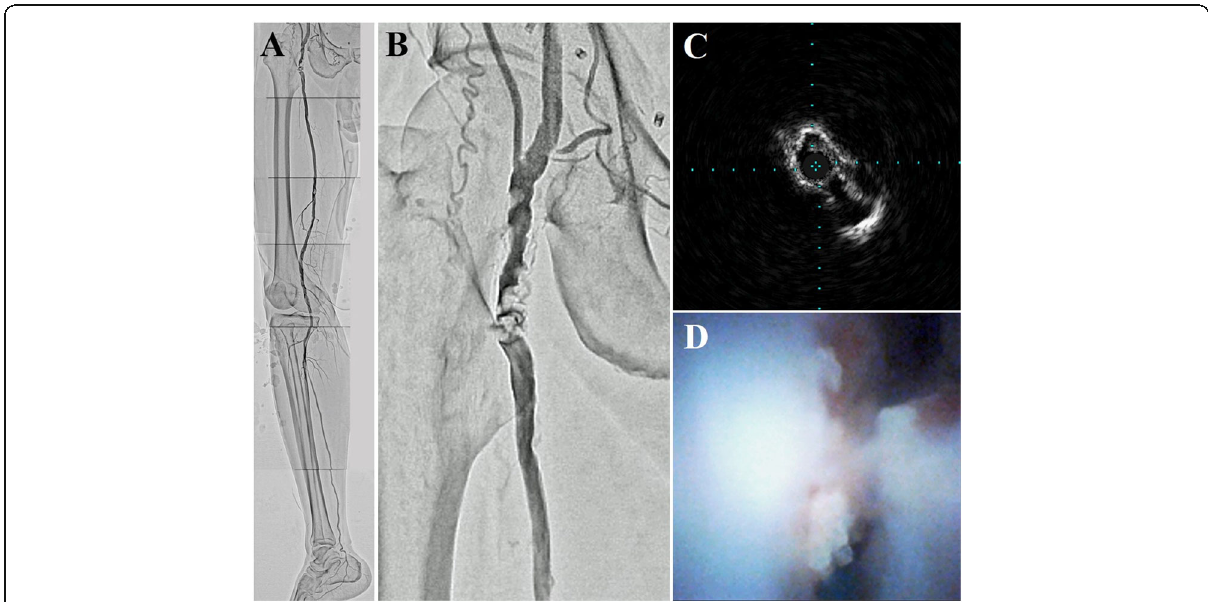
Fig. 1 A,B Initial angiography showing a filling defect of contrast medium in the common femoral artery and one straight line through the posterior tibial artery. Initial intravascular ultrasonography ( C ) and angioscopy ( D ) images demonstrating a calcified mass protruding into